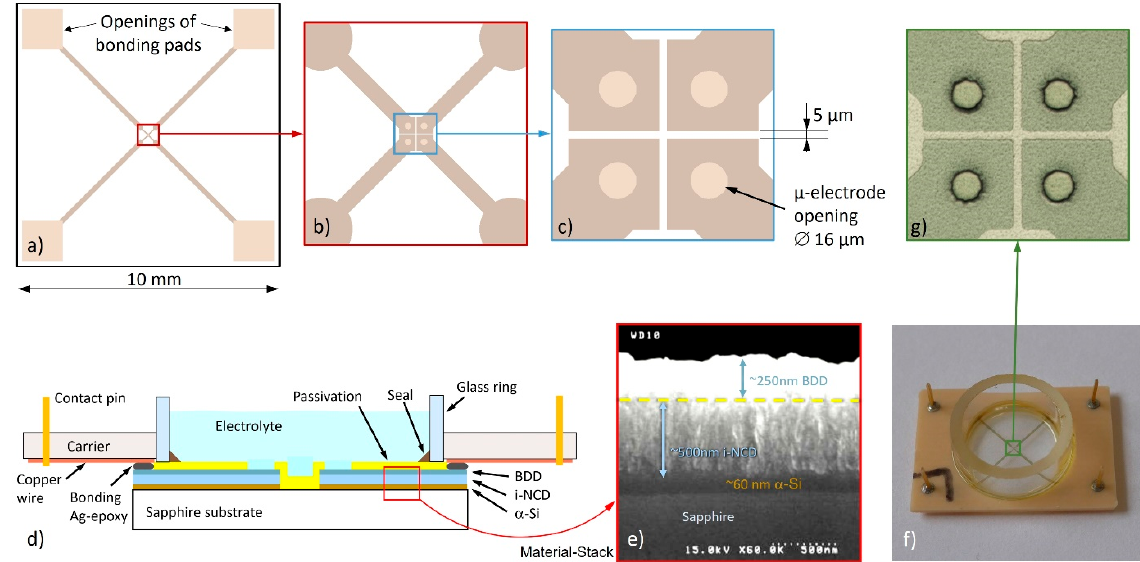
Figure 1. The microelectrodes chip. ( a ) Layout of the 10 × 10 mm device; ( b , c ) progressive magnifi- cations of the core region with the microelectrodes; ( d ) scheme of device cross-section showing the various layers and features; ( e ) SEM-picture showing the cross-section of the material stack before the deposition of the passivation layer; ( f ) assembled chip with the 200 μ L sensing chamber; ( g ) micrograph showing the same region depicted in ( c ) of the actual chip.